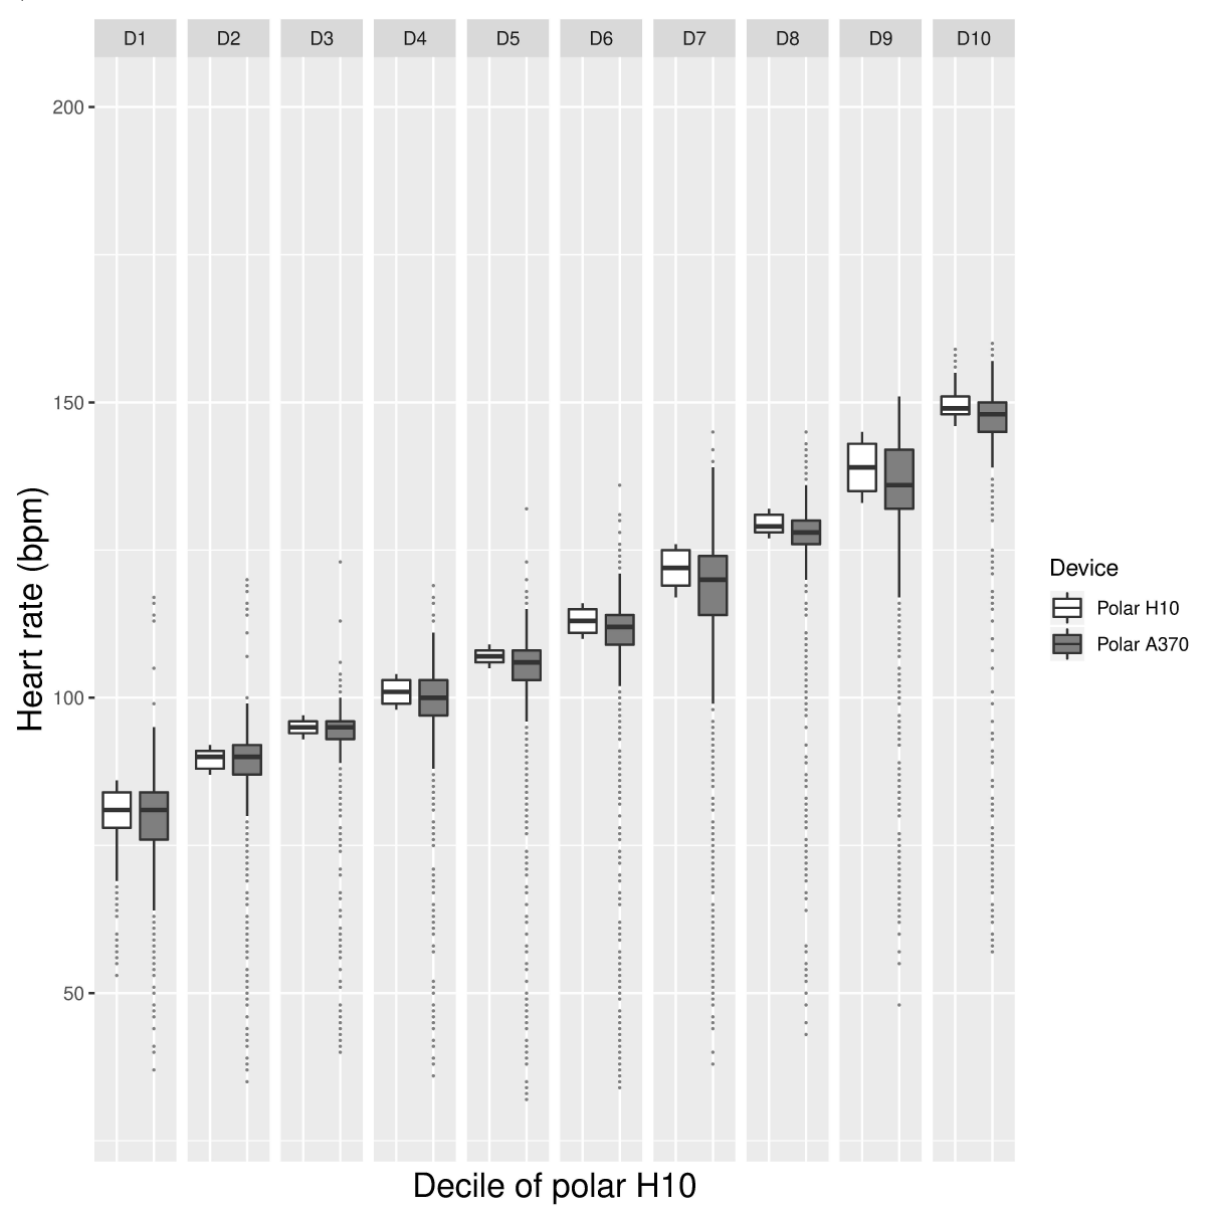
Figure 5. Laboratory phase: box plot providing by-decile comparisons of mean Polar H10 (white) and Polar A370 HR data (gray). HR: heart rate; bpm: beats per